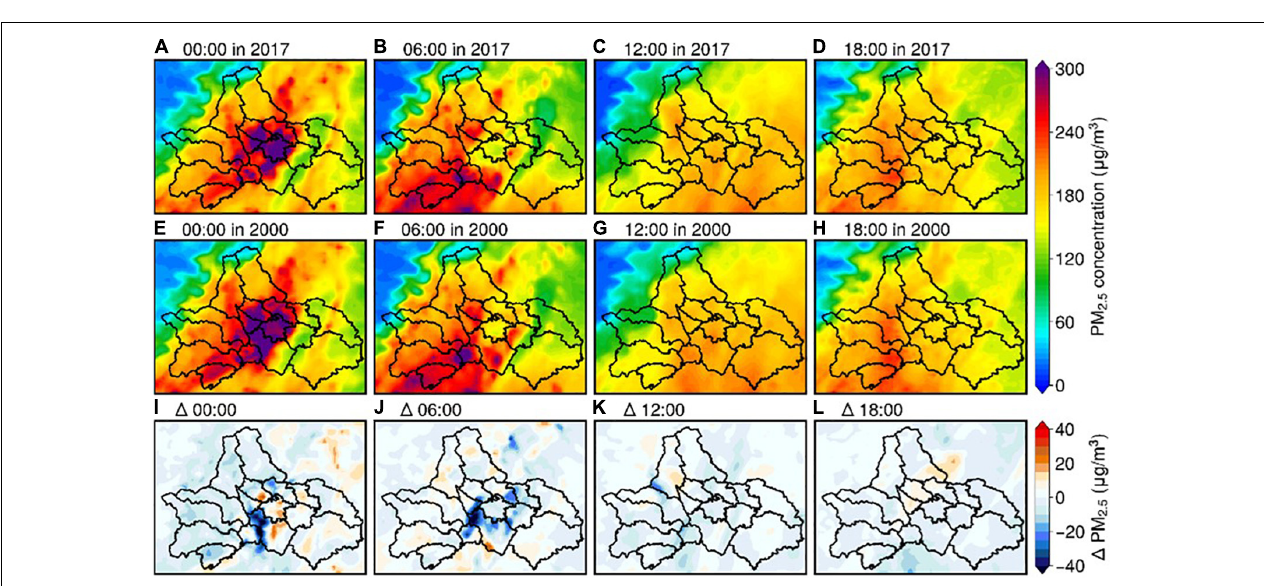
FIGURE 6 | Spatial map of VI variations induced by land use change between 2000 and 2017 at 00:00, 06:00, 12:00, and 18:00 in winter (A–D) and summer (E–H) periods.